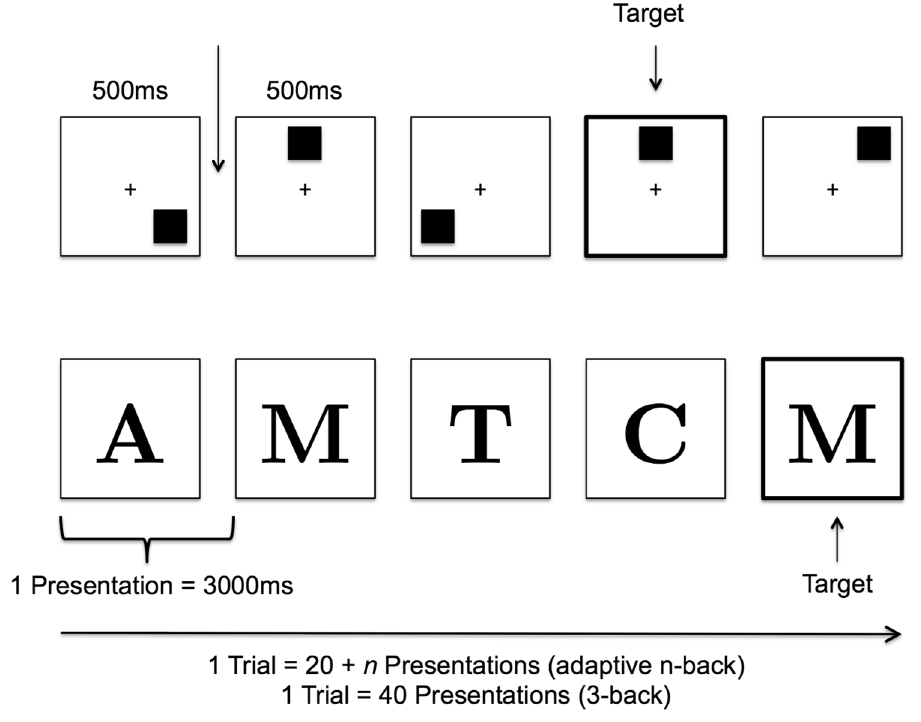
Figure 5. Schematic depiction of the training and transfer tasks (Figure adapted from Jaeggi et al .,